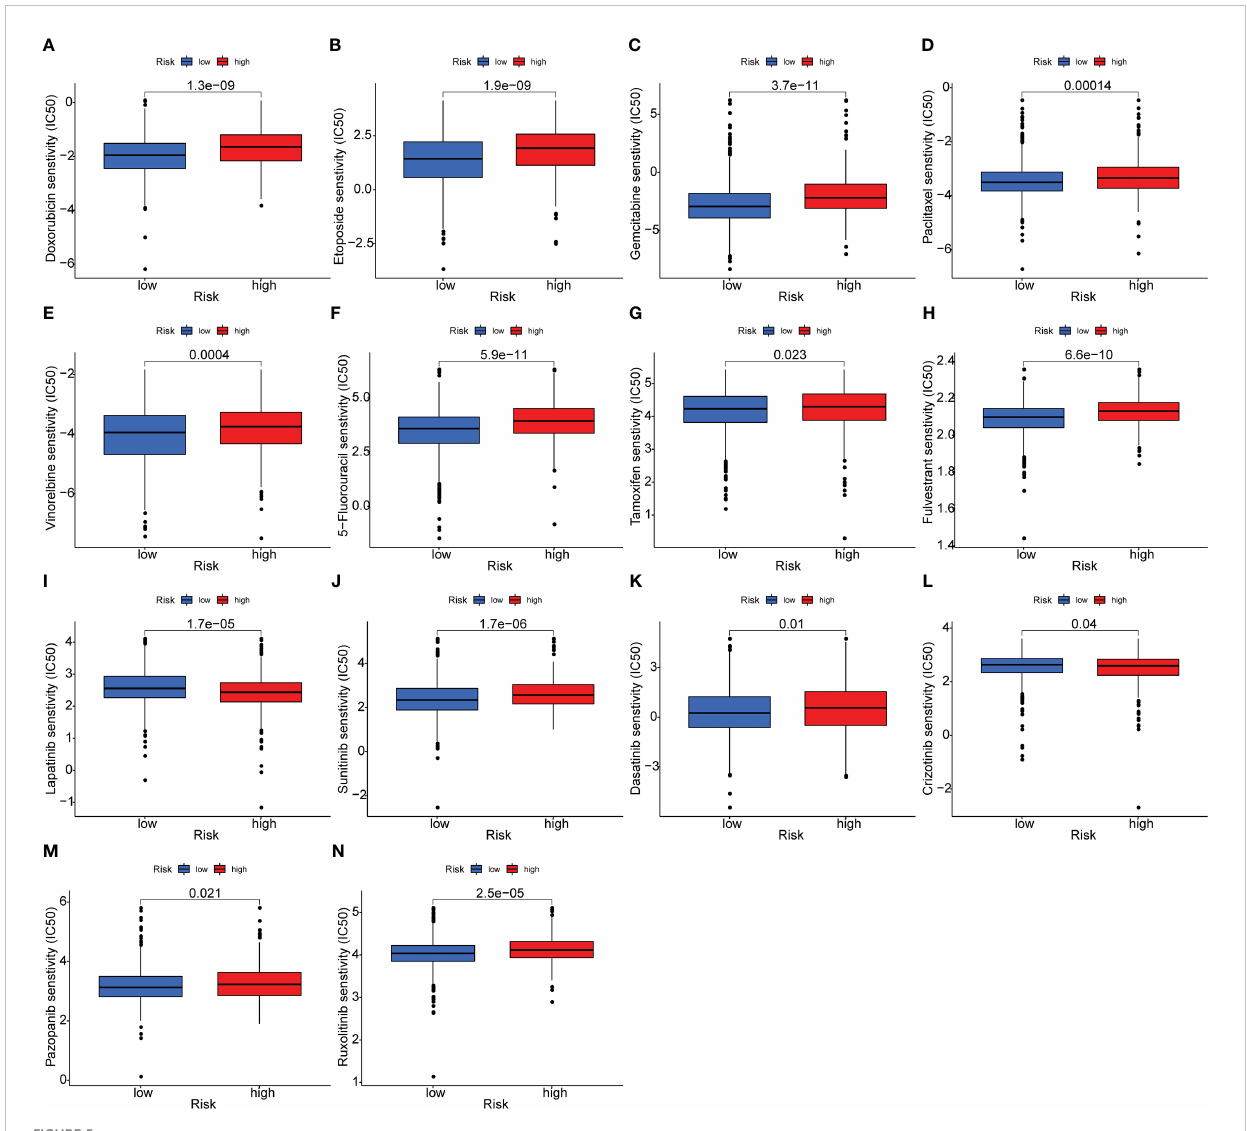
FIGURE 5 Analysis of the association between the risk model and chemotherapeutics, endocrine therapy, and targeted therapy. (A – F) The model predicting the sensitivity to chemosensitivity. It was estimated that low-risk patients had lower IC50 for chemotherapeutics of doxorubicin, etoposide, gemcitabine, paclitaxel, vinorelbine and 5- fl uorouracil. (G, H) The model predicting the sensitivity to endocrine therapy. It was estimated that low-risk patients had lower IC50 of tamoxifen and fulvestrant. (I – N) The model predicting the sensitivity to targeted therapy. It was estimated that low-risk patients had lower IC50 of lapatinib, sunitinib, dasatinib, crizotinib, pazopanib and